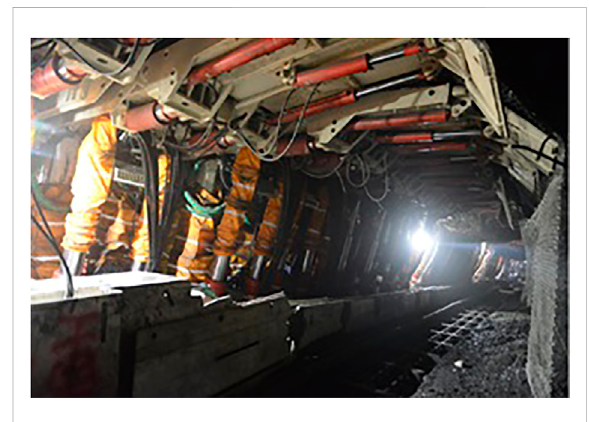
FIGURE 9 Special paste fi lling support for the fi lling working